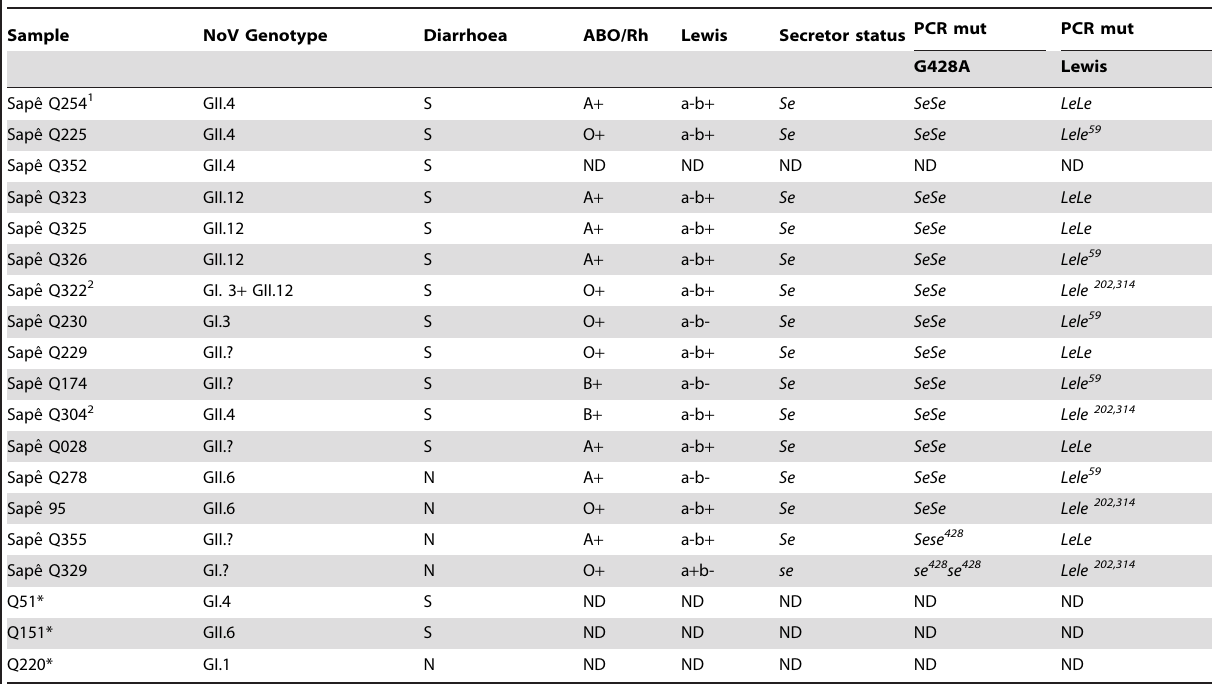
Table 3. Genotype of NoVs and HBGA profile of infected